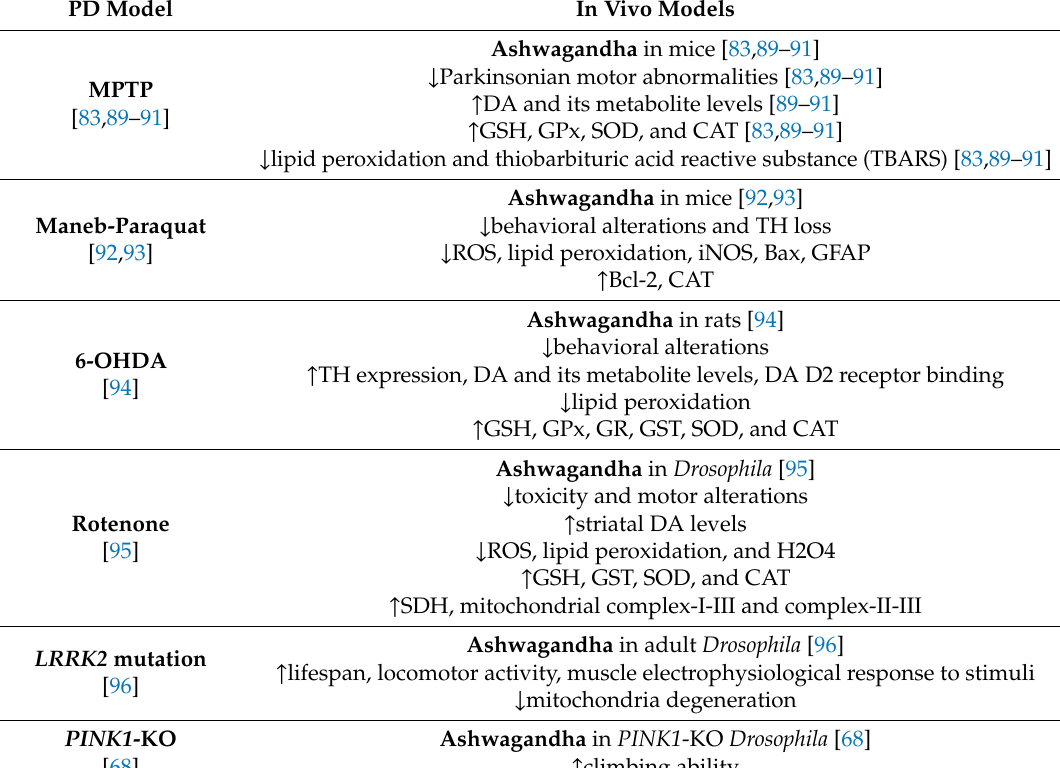
Table 5. Neuroprotective e ff ects of W. somnifera (ashwagandha) in PD